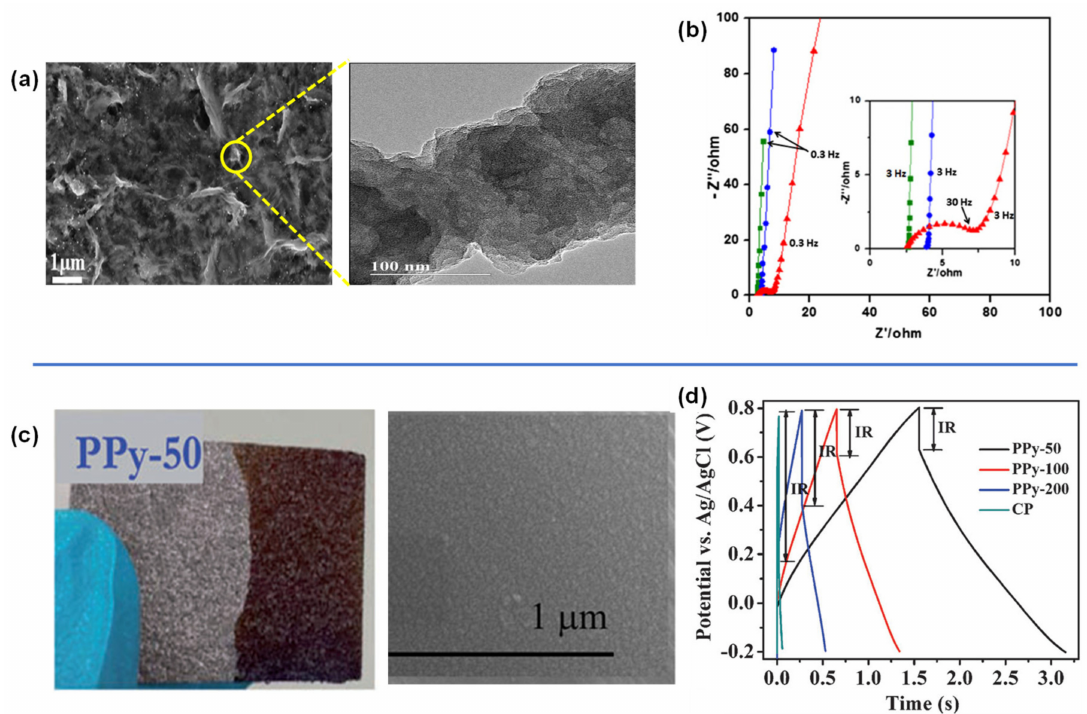
Figure 8. ( a , b ) Surface morphology and Nyquist plots of rGO modified with PPy, ( c ) optical and SEM images of PPy deposited on CP at 50 mV/s, and ( d ) Comparison of GCD curves of carbon paper and PPy-CP fabricated at various scan rates. Reproduced with permission from Refs.